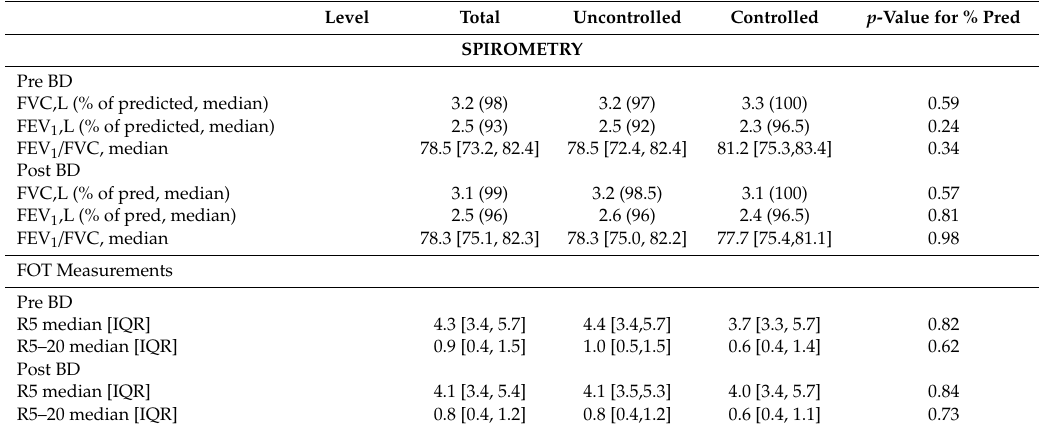
Table 3. Spirometry and forced oscillation measures in patients who were uncontrolled at V1 (n = 60). Level Total Uncontrolled Controlled p -Value for % Pred SPIROMETRY Pre BD FVC,L (% of predicted, median) 3.2